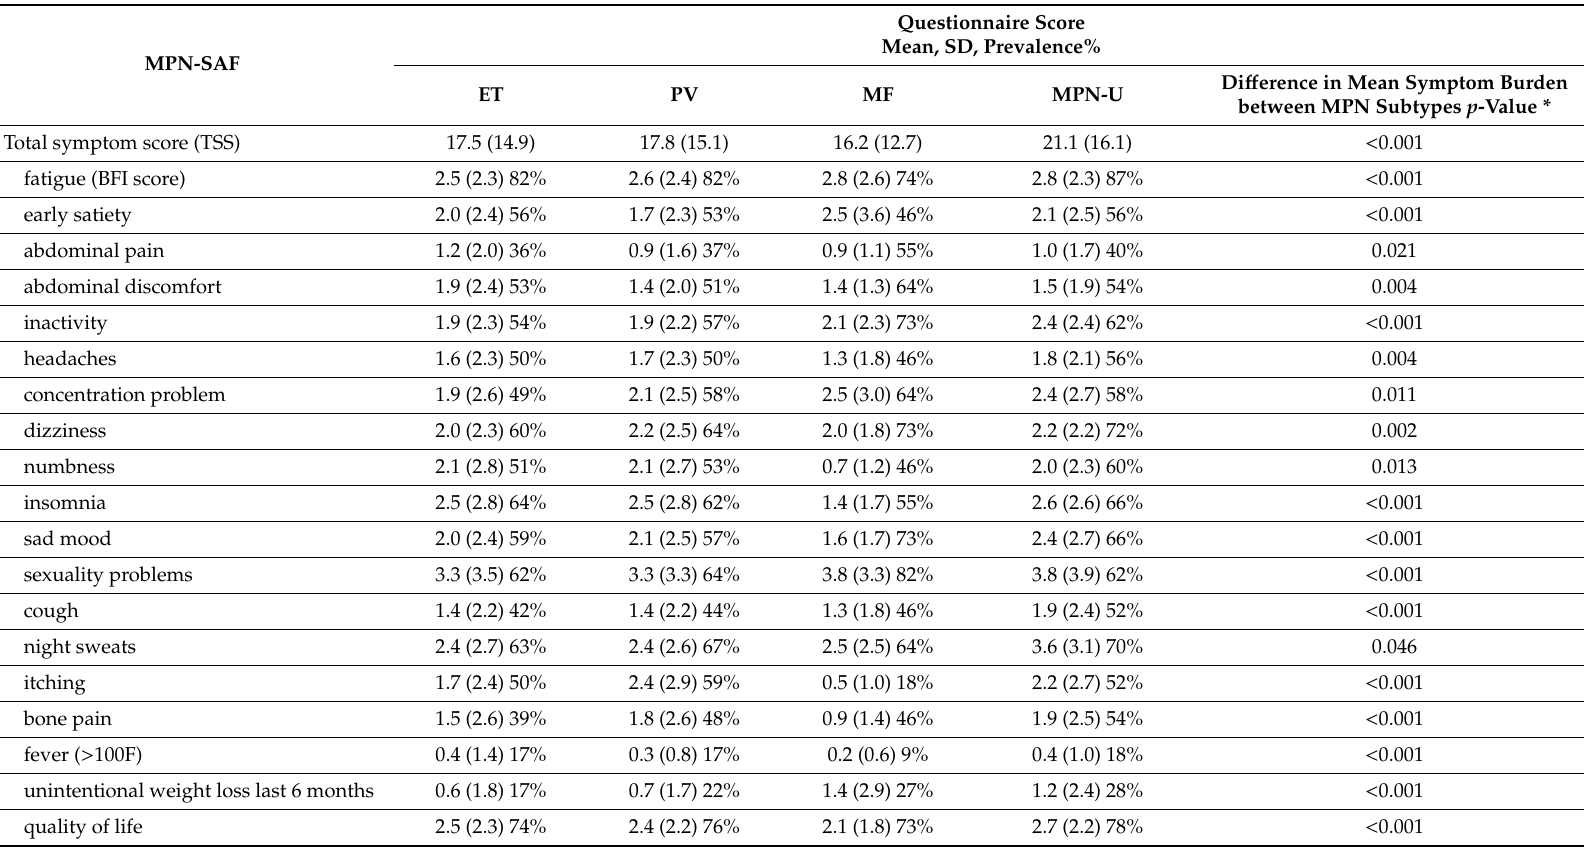
Table 3. Symptoms, symptom burden, and QoL. Di ff erences between participants with di ff erent MPN